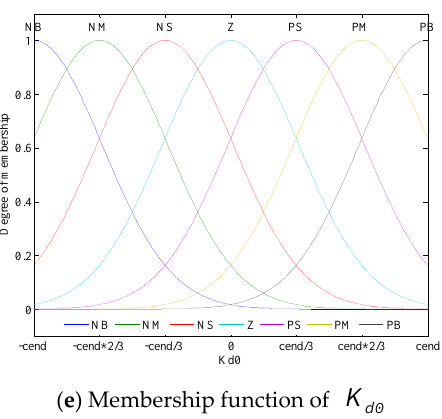
Figure 5. Membership functions of input variables and output variables.